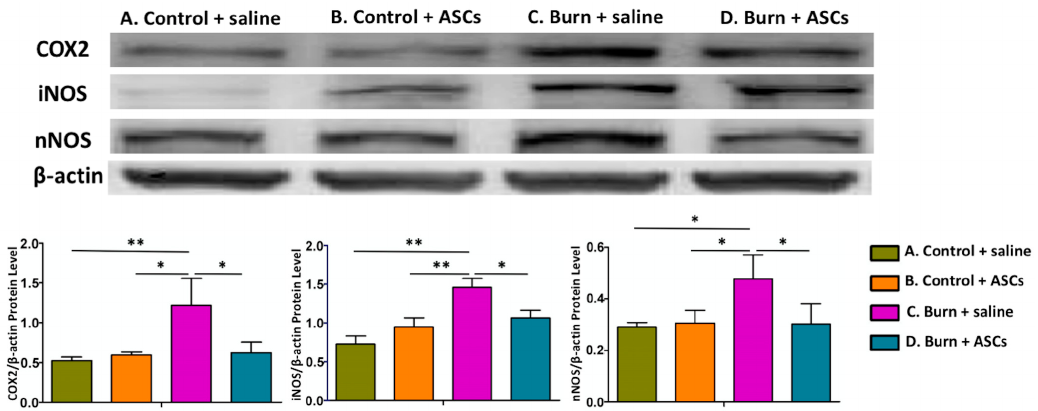
Figure 5. Attenuated central neuroinflammation in spinal cord dorsal horn after ASC transplantations. Four weeks after subcutaneous ASC transplantation or saline injection into burn-injured skin, western blot analyses of dorsal horn specimens showed significantly increased levels of inflammatory proteins (COX-2, iNOS and nNOS) in Group C, compared to Groups A and D, suggesting that a skin burn induces concurrent spinal cord neuroinflammation that is attenuated by ASCs. Upper four rows: Representative western blot images. Lower panel: Quantitative analyses. Sample sizes were >3 per test. β -actin was used as an internal protein control. (** p < 0.01, * p < 0.05).